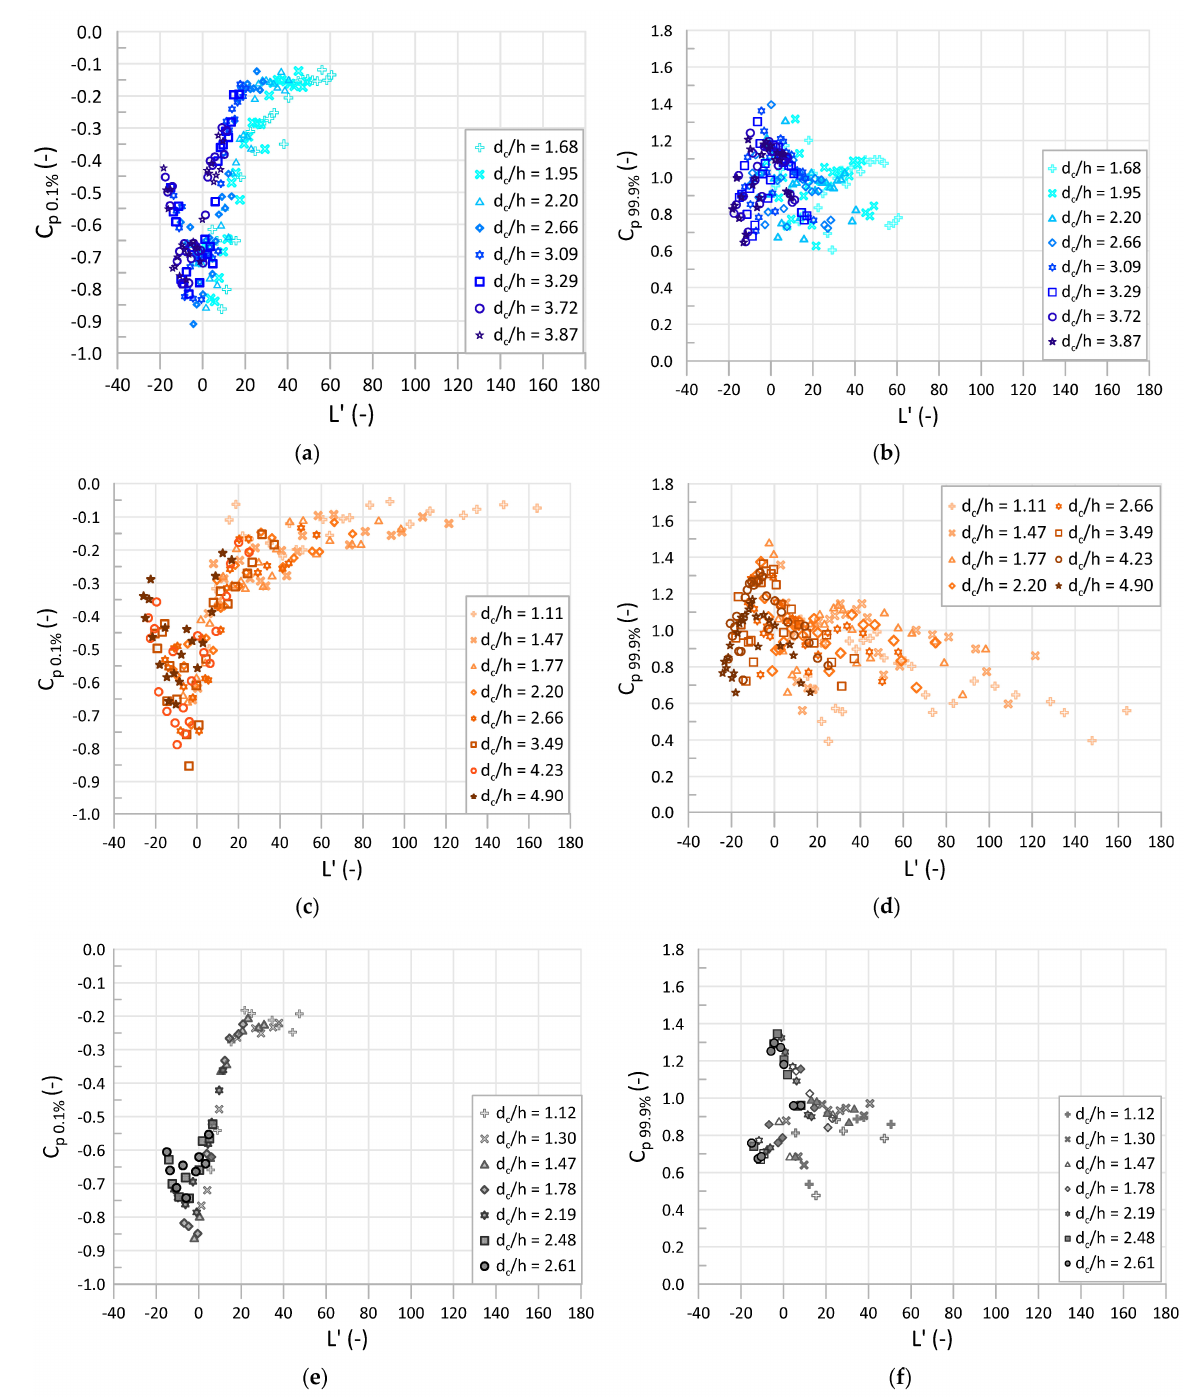
Figure 9. Streamwise development of the 0.1% (left) and 99.9% (right) extreme pressure coefficients, at the LOH I (blue color), LOH II (brown color), and LAHE (grey color) stepped chutes: ( a , c , e ) vertical face of the step, near the outer edge; ( b , d , f ) horizontal face of the step, near the outer